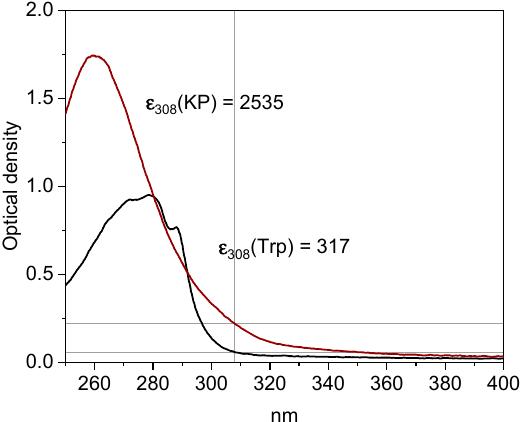
Figure 8. Absorption spectra of KP (0.1 mM) and Trp (0.2 mM) in bicelles at pH 7.4. Extinction coefficients are shown for wavelength of laser light, 308 nm.